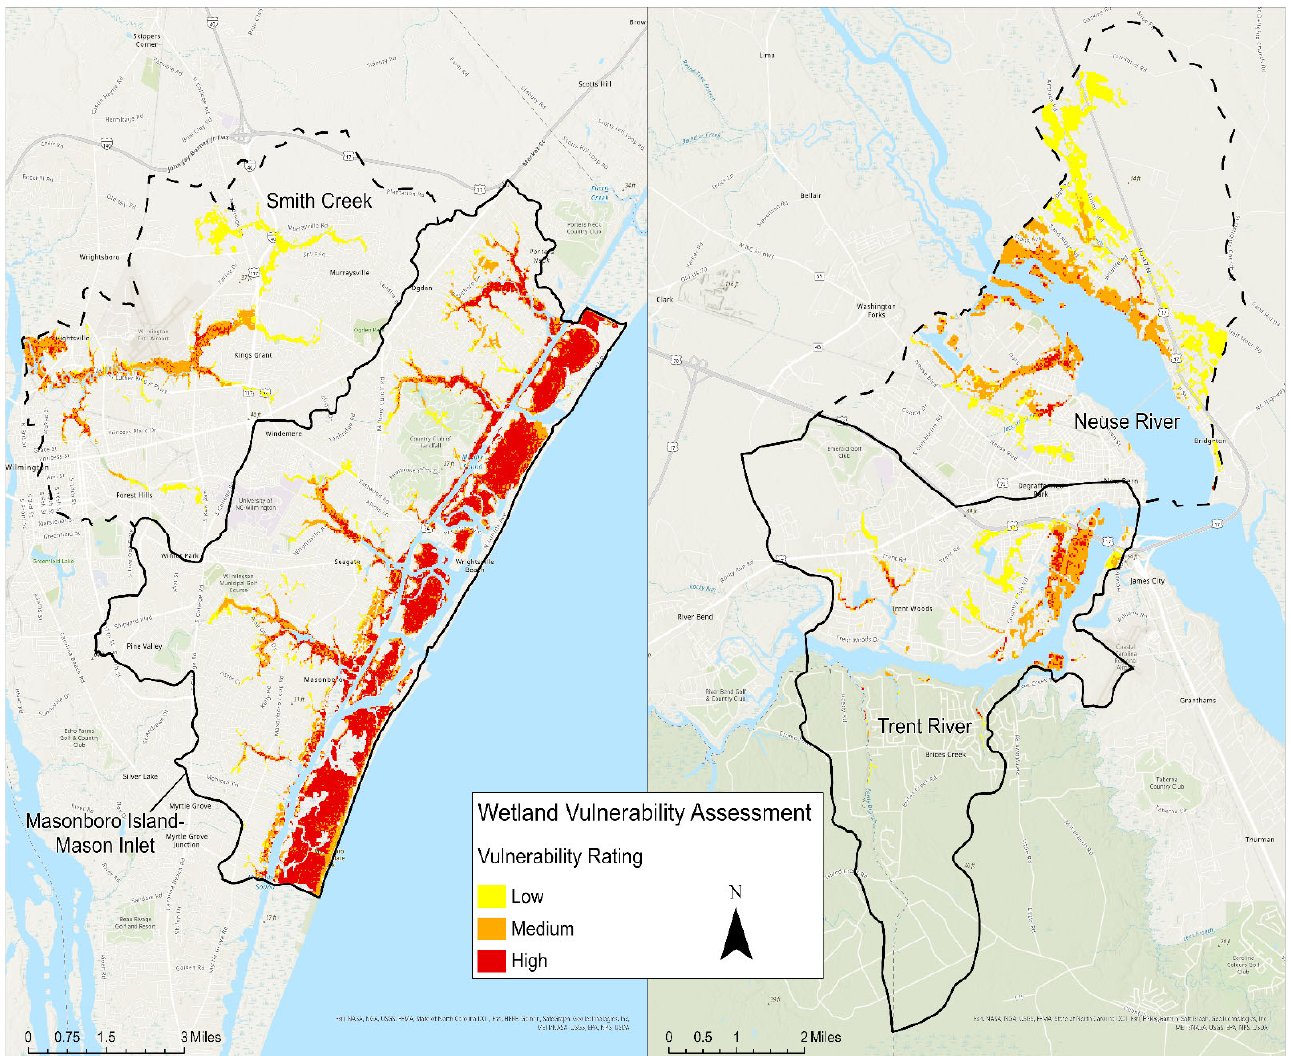
Figure 5. Wetland vulnerability assessment of the Masonboro Island–Mason Inlet and Smith Creek subwatersheds, NC showing categorical vulnerability rankings. Table 4. Combined wetland vulnerability assessment metrics for the four study areas in acres and as a percentage of the HUC ‐ 12 impacted.